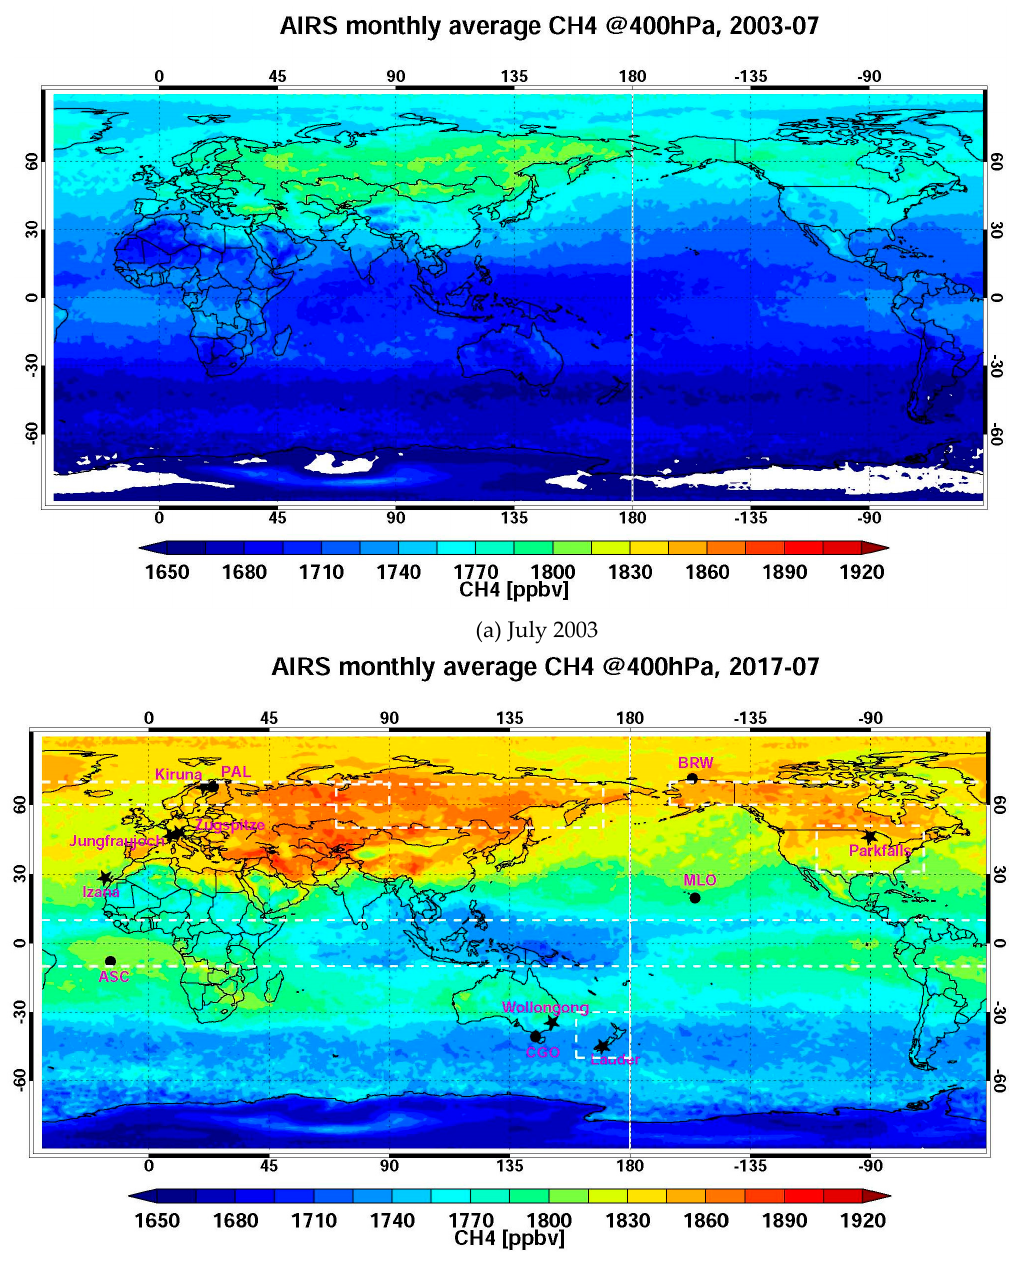
Figure 1. Global monthly mean CH 4 at 400 hPa level in July 2003 ( a ) and 2017 ( b ). Box areas indicated by dotted lines represent regions (listed in Table 1) used to calculate the Atmospheric Infrared Sounder (AIRS) average CH 4 . Ground-based stations with surface CH 4 measurements used in this paper are marked with circles, as well as the ground sites with CH 4 total column measurements (listed in Table 2, Section 2.2) marked with stars. Table 1. List of regions used to calculate the average of AIRS CH 4